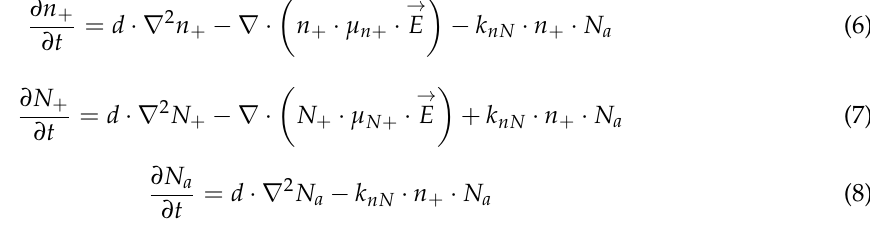
between small particles and large aerosol particles with a value of 2.9 × 10 − 6 m 3 /s, d is the particle diffusion rate with a value of 1 m 2 /s, e is the charge of elementary charge, and ε 0 is the dielectric constant of air with a value of 8.854187 × 10 − 12 F/m.